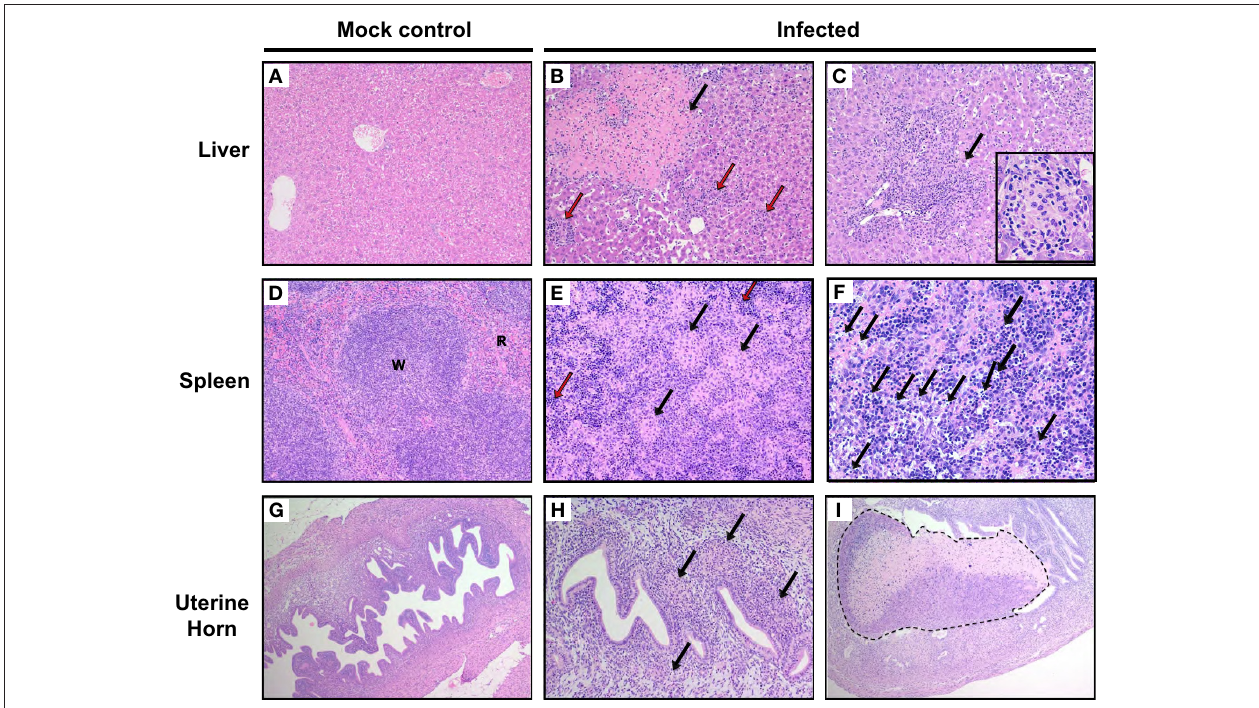
FIGURE 3 | Pathological outcomes in mice infected with W. chondrophila . Liver, spleen, and uterine horn tissues of mice infected with 10 9 W. chondrophila and mock were collected at day 14 p.i. and analyzed for histological changes by H&E staining under light microscope. (A) Liver (200X): normal hepatic parenchyma in a control mouse. (B) Liver (200X): a large area of perivascular parenchymal coagulative necrosis (arrow) and leukocytic infiltration (red arrows) is observed in an infected mouse 14 days after infection. (C) Liver (200X): perivascular coalescing foci of histiocytic and neutrophilic aggregates within the hepatic parenchyma (arrow). The insert depicts a granuloma (400X). (D) Spleen (200X): normal distribution of white (W) and red pulp (R) in a control animal. (E) Spleen (200X): the white and red pulp are diffusely replaced by nodular aggregates of histiocytes (arrow) in a infected mouse. A prominent EMH response is visible in the remnants of red pulp (red arrow). (F) Spleen (400X): increased apoptotic cells in the red and white pulp of an infected mouse (arrows). (G) Uterus (100X): normal appearance of the uterus in a control mouse. (H) Uterus (200X): multifocal and periglandular infiltration of histiocytes (arrow) and few neutrophils in the endometrium of a W. chondrophila infected mouse. (I) (100X): left uterine horn of an infected mouse: a large deciduoma undergoing degeneration obliterates almost completely the lumen of the organ (dashed line). Results are representative of four individual